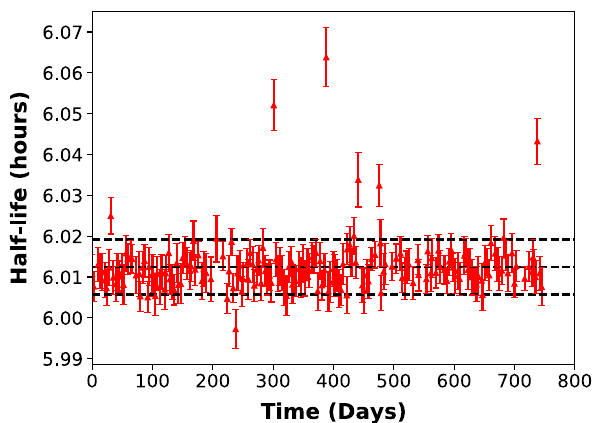
Fig. 3 Generalized L–S periodogram for 123 I shown upto frequency of 40/year. We also searched for statistically significant peaks at higher frequencies, upto 123/year, but did not find any